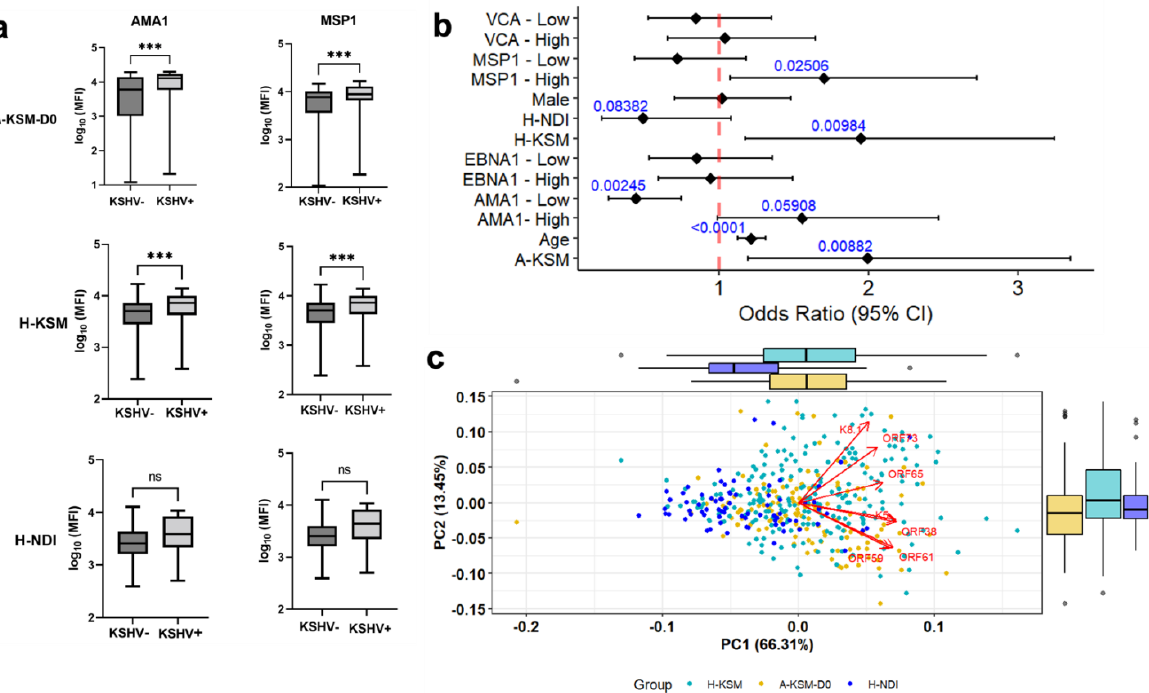
Figure 1. Distinct KSHV serological signature during acute malaria episodes. ( a ) Plot of anti-malarial IgG antibodies in KSHV seropositive relative to seronegative children from western Kenya. Significant differences are based on the Wilcoxon rank-sum test with Benjamini–Hochberg correction for multiple comparisons where appropriate (ns: p > 0.05; *** p < 0.001). Boxplots include the sample medians, minimum/maximum values, and first/third quartiles. ( b ) Forest plot of multivariate logistic regression analysis of determinants of KSHV seropositivity in the three study populations. ( c ) Study participants are clustered based on their anti-KSHV IgG antibodies into malaria-endemic vs. sporadic regions (PC 1) and acute malaria vs. healthy children from Kisumu (PC 2). Outer boxplots and whiskers show distribution of KSHV IgGs in A-KSM and H-KSM compared to H-NDI KSHV IgG combinations along both principal component 1 (PC1) and PC2. Abbreviations: A-KSM, chil- dren with acute malaria from Kisumu; H-KSM, healthy children from Kisumu; H-NDI, healthy chil- dren from Nandi; VCA, EBV Viral Capsid Antigen; EBNA1, Epstein – Barr nuclear antigen 1; MSP1, P. falciparum malaria Merozoite surface protein-1; AMA1, P. falciparum malaria Apical Membrane Antigen-1. 2.3. KSHV Lytic Antigens Are Increased in Patients with Acute Malaria To determine the specific KSHV antigens that are elevated during acute malaria, we compared antibody levels to these antigens in the three cohorts. Consistent with our PCA characterization, we identified distinct antibody signatures for the KSHV antigens ORF59, K8.1, ORF38, and ORF73 across the three study populations. IgG antibodies against ORF73 were significantly higher in healthy subjects compared to A-KSM-D0 subjects. K8.1 IgG antibodies were also slightly elevated in H-KSM while ORF59 IgG was slightly ele- vated in A-KSM-D0 subjects compared to H-KSM (Figure 2a). In contrast, anti-ORF38 IgGs were significantly elevated in acute malaria patients from Kisumu at day 3 compared to healthy children from the same region (Figure 2a). Delayed early antigens such as K5, ORF61, and ORF65 had comparable IgG antibody levels in the three study populations (Figure S1). As a comparator, we examined EBV, which is known to become reactivated during acute malaria. We found EBV anti-VCA but not EBNA1 IgG levels were signifi- cantly higher in A-KSM children at day 0 compared to both H-KSM and H-NDI children (Figure 2b) and showed a modest positive correlation with IgG against KSHV antigens,